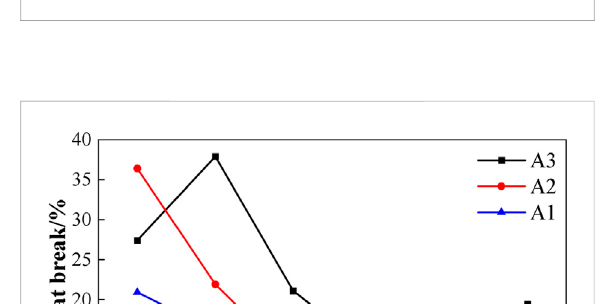
FIGURE 5 Effect of sodium alginate on the tensile strength of microbial repair materials.